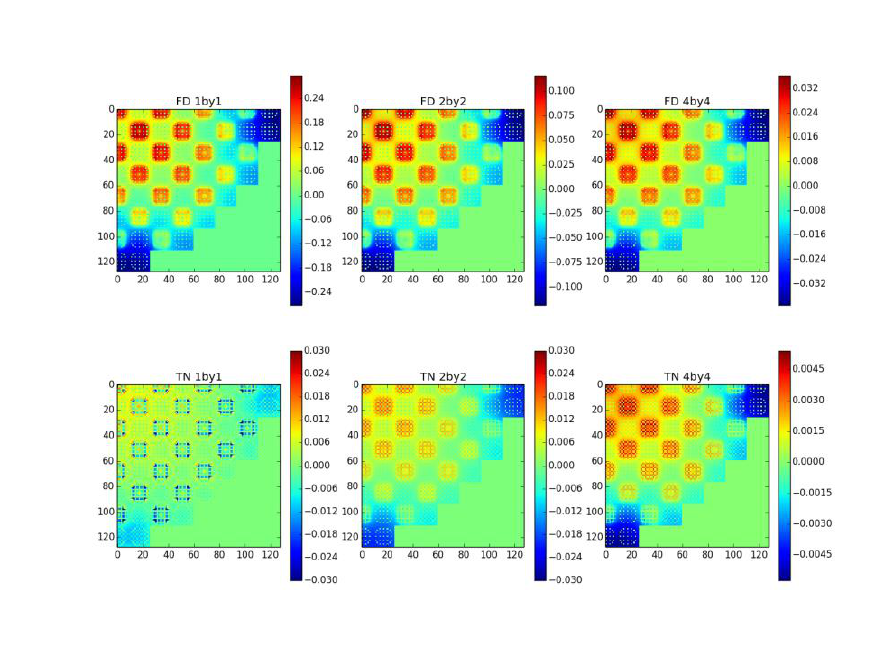
Figure 1. Relative Error of Power of 2D 4G Problem